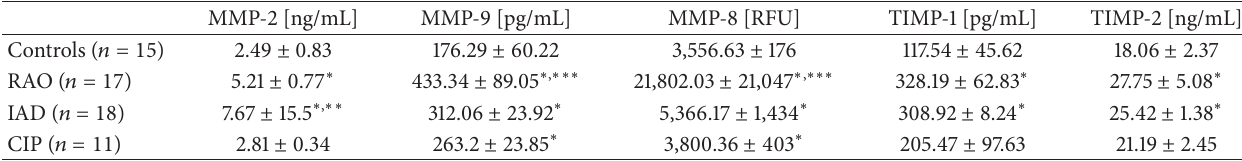
Table 6: MMP-2, MMP-9, TIMP-1, TIMP-2 ELISA, and MMP-8 fluorimetry measurements. The results are expressed as mean ± SD. ∗ shows significant increases to controls at 𝑝 < 0.05 , ∗∗ significant increase in IAD compared to RAO and CIP, and ∗ ∗ ∗ significant increase in RAO compared to IAD and CIP. RAO: recurrent airway obstruction, IAD: inflammatory airway disease, and CIP: chronic interstitial pneumopathy.